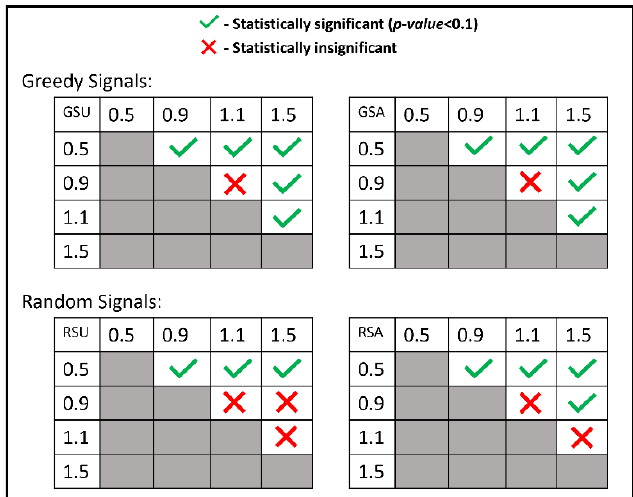
Figure 7. ( a ) Information purchasing rate as a function of the information cost. ( b ) Experts’ revenue as a function of the information cost.